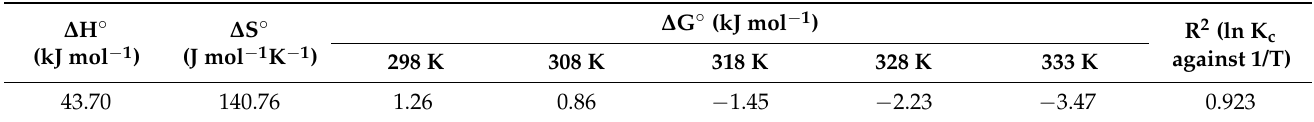
Table 2. Adsorption thermodynamic parameters of CR dye onto 2Clph-BU-Cs adsorbent (m = 0.01 g,